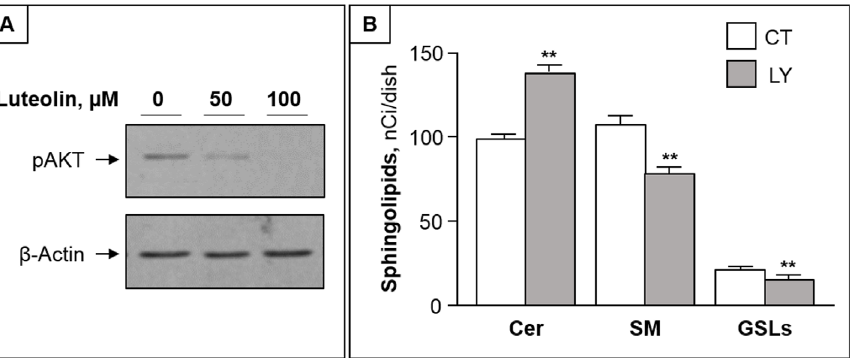
Fig 4. Akt inhibition by luteolin is involved in its effect on ceramide metabolism. (A) CCs were treated with 50 and 100 μ M of luteolin for 2 h and submitted to immunoblotting with anti-pAKT antibodies. β -actin was used as loading control. (B) Cells were submitted to pulse with 3 H-Sph in the absence (CT) or presence of LY294002 for 2h. The levels of ceramide (Cer), sphingomyelin (SM) and glycosphingolipids (GSLs) are reported as mean ± S.D. of at least three independent experiments. ** , p < 0.01 vs CT